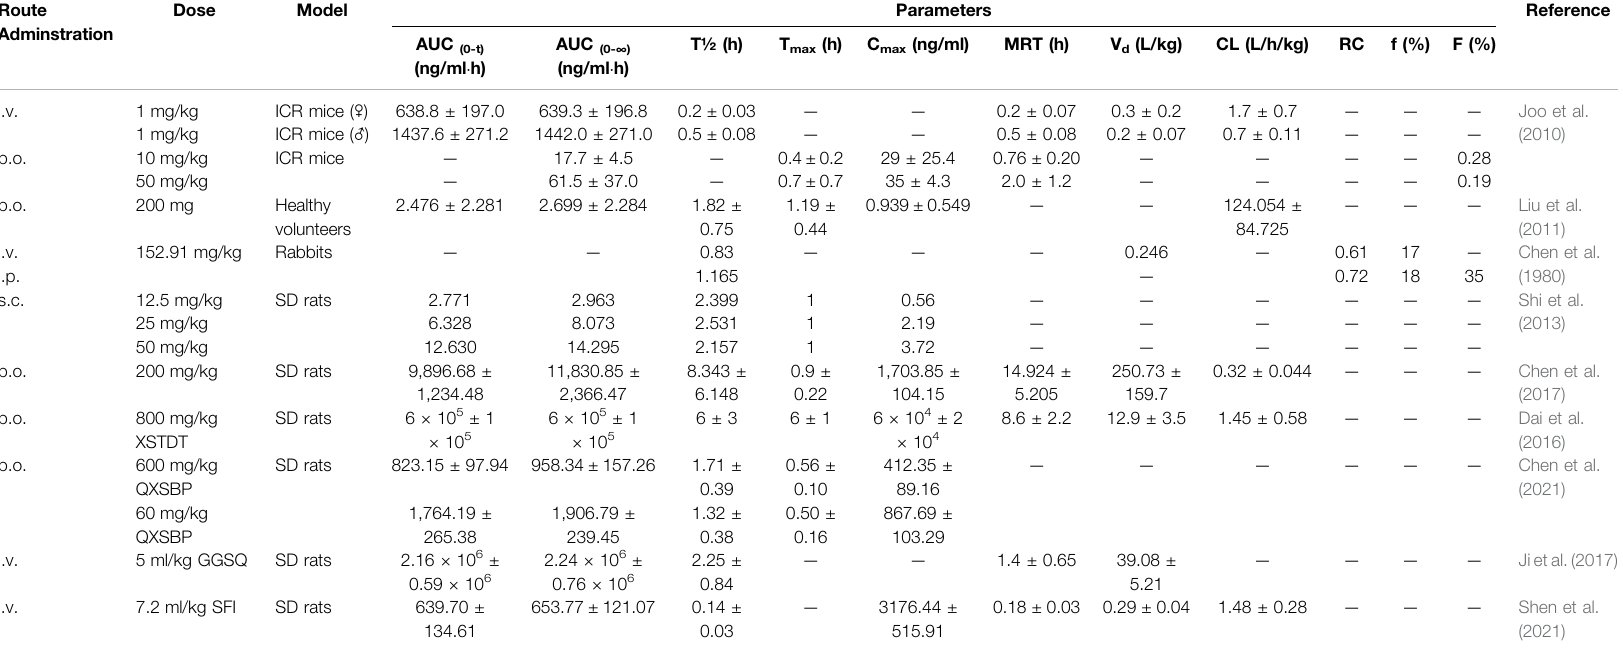
TABLE 7 | The main pharmacokinetic parameters of Re. Route